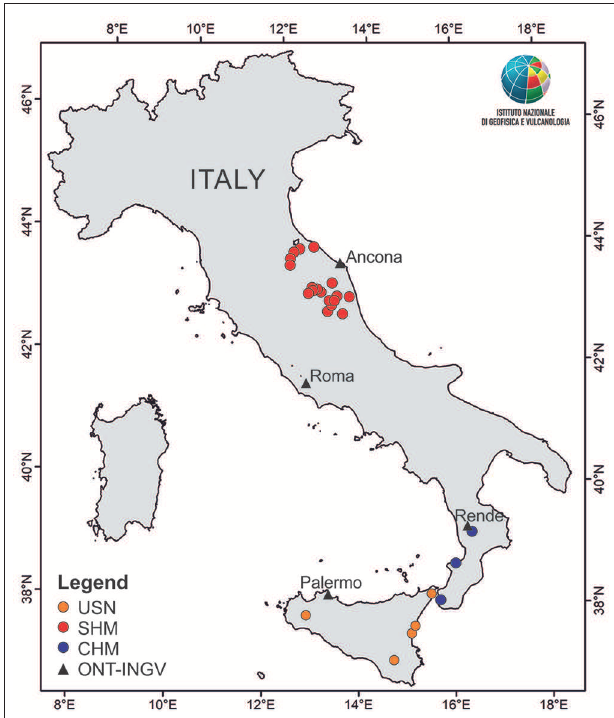
FIGURE 2 | Map of the networks developed by INGV-ONT. USN, urban seismic networks; SHM, structural health monitoring of the PSBs; CHM, cultural heritage monitoring; ONT-INGV, Italian earthquake observatory